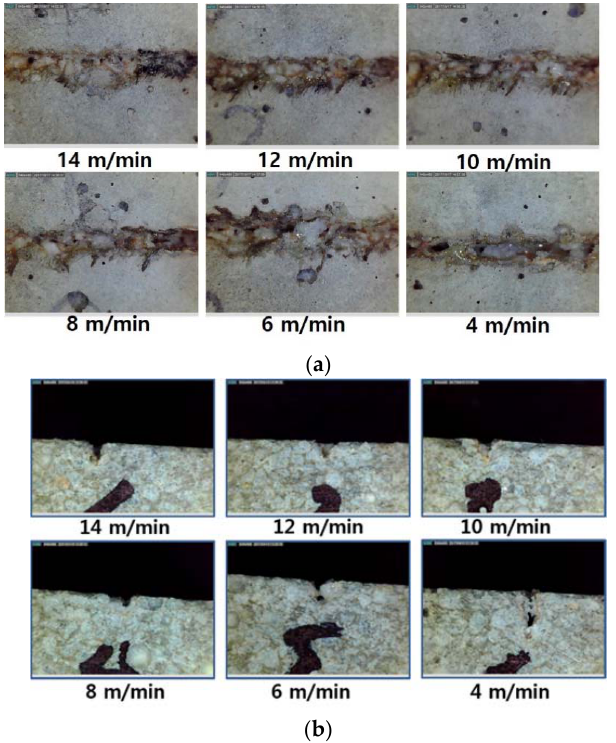
Figure 6. Kerf width ( a ) and penetration depth ( b ) vs. laser moving speed for LM0.4.